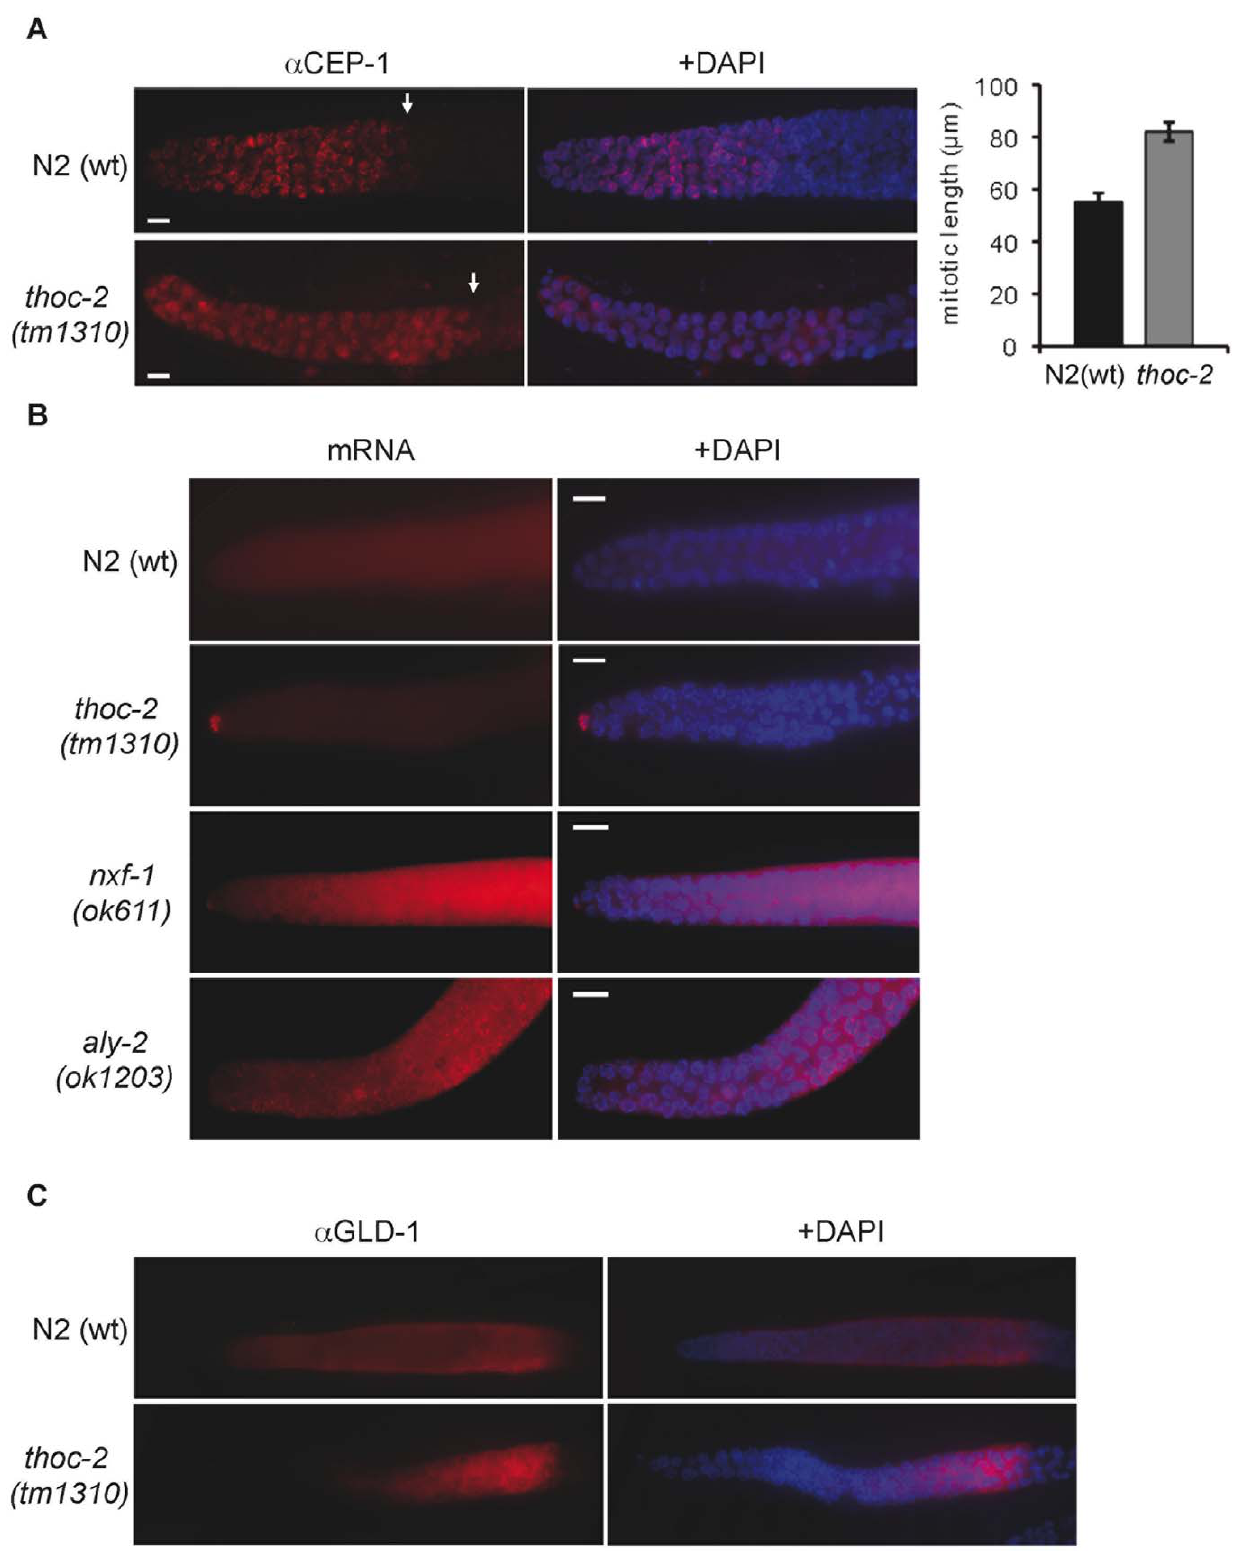
Figure 2. Defective mitosis in thoc-2 mutants. ( A ) Representative images of fixed mitotic nuclei from N2(wt) and thoc-2(tm1310) animals immunostained with the mitotic marker CEP-1, and quantification of the mitotic region length. Error bars indicate standard error of mean (n=15). ( B ) Poly-A mRNA visualized by FISH using a poly-dT oligonucleotide conjugated with Cy3 in germlines from animals of the indicated genotype. ( C ) Representative images of fixed mitotic nuclei from animals of the indicated genotype immunostained with GLD-1.